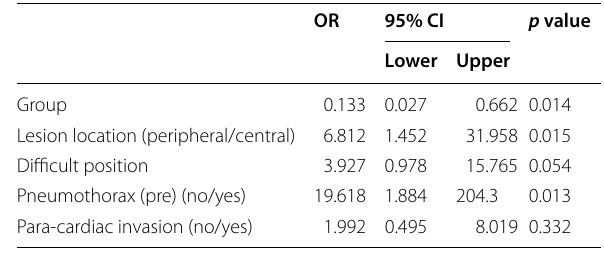
Table 5 Multivariate regression analysis for risk factors influencing the chest tube insertion